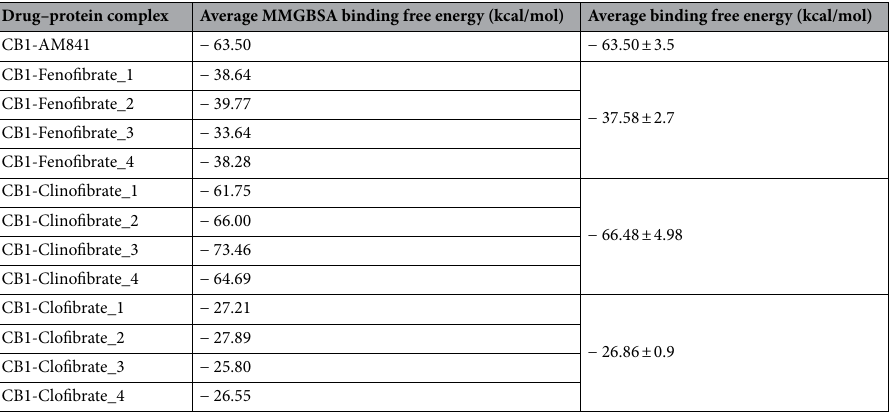
Table 2. Binding Free Energy Results for the four ligands (AM841, Fenofibrate, Clinofibrate and Clofibrate). The protein–ligand complexes are numbered sequentially from 1 to 4 for the fibrate ligands referring to four independent poses obtained from